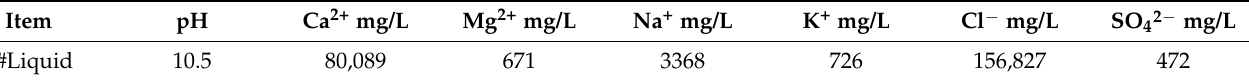
Table 4. Composition of the filtered solution from 3# filter press.